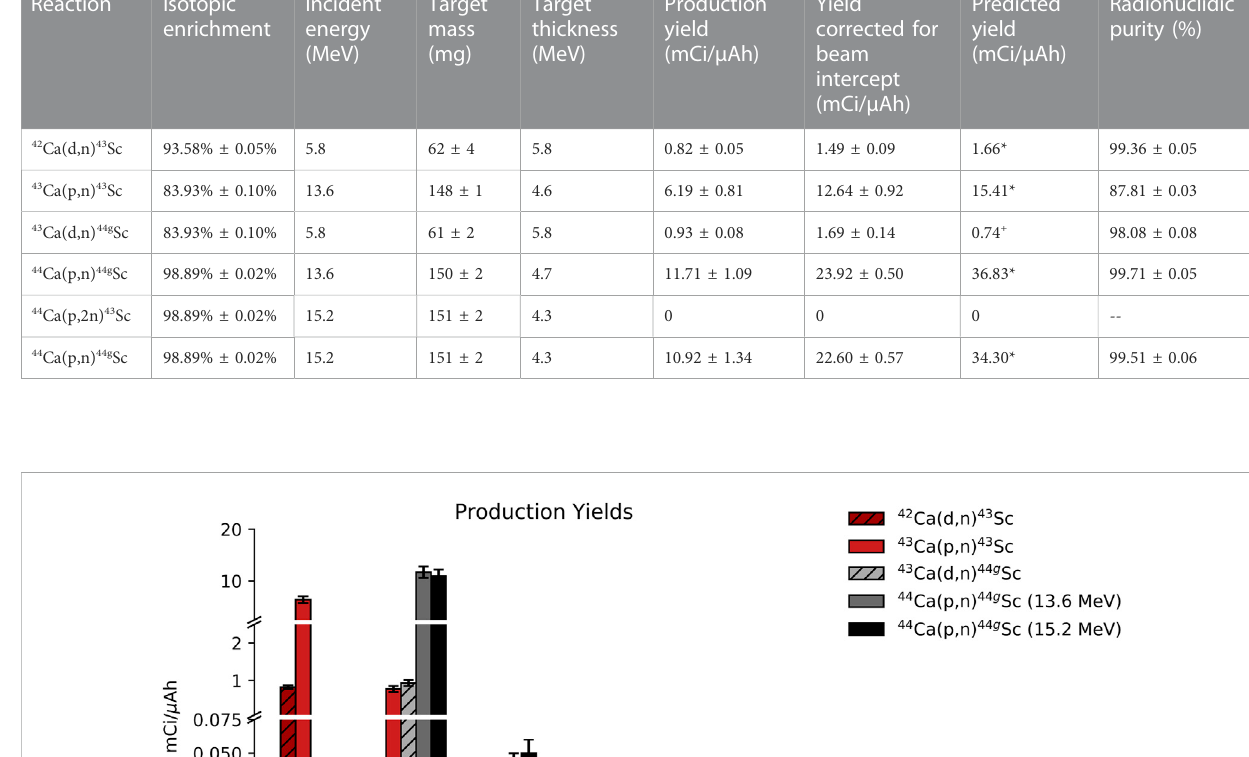
TABLE 4 Observed production yields for the 5 routes investigated along with target masses and energy thickness (Carzaniga, et al., 2017; Carzaniga, et al., 2019)* (de Waal, et al., 1971) + . Reaction